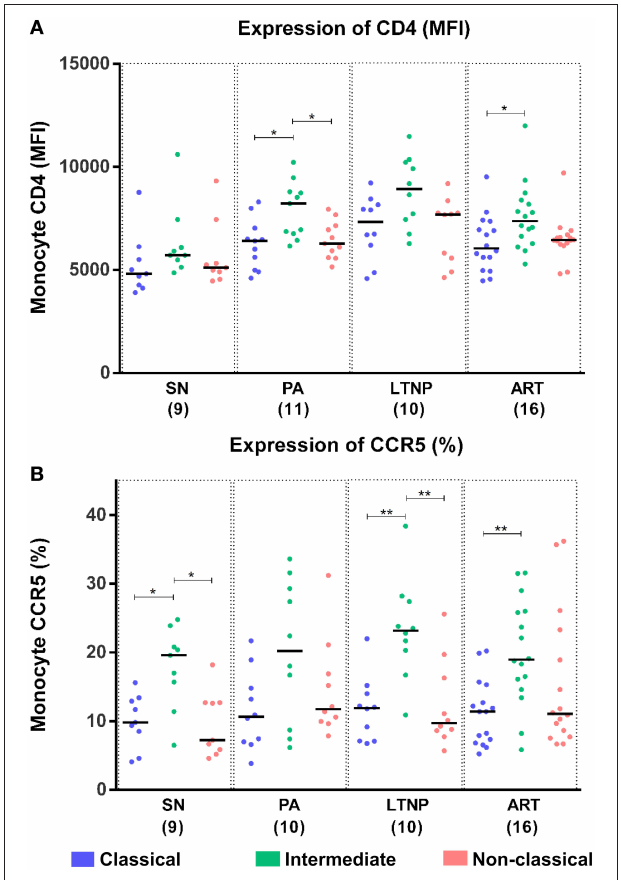
FIGURE 4 | Differential expression of activation markers on monocytes subsets. (A,B) Expression of monocyte activation marker—HLA-DR (MFI) and marker for M2 phenotype—CD206 (%), respectively across monocyte subsets for each cohort. Kruskal-Wallis ANOVA followed by Dunn’s multiple comparison test was used to assess significance; * P < 0.05; ** P < 0.01; *** P < 0.001; **** P <